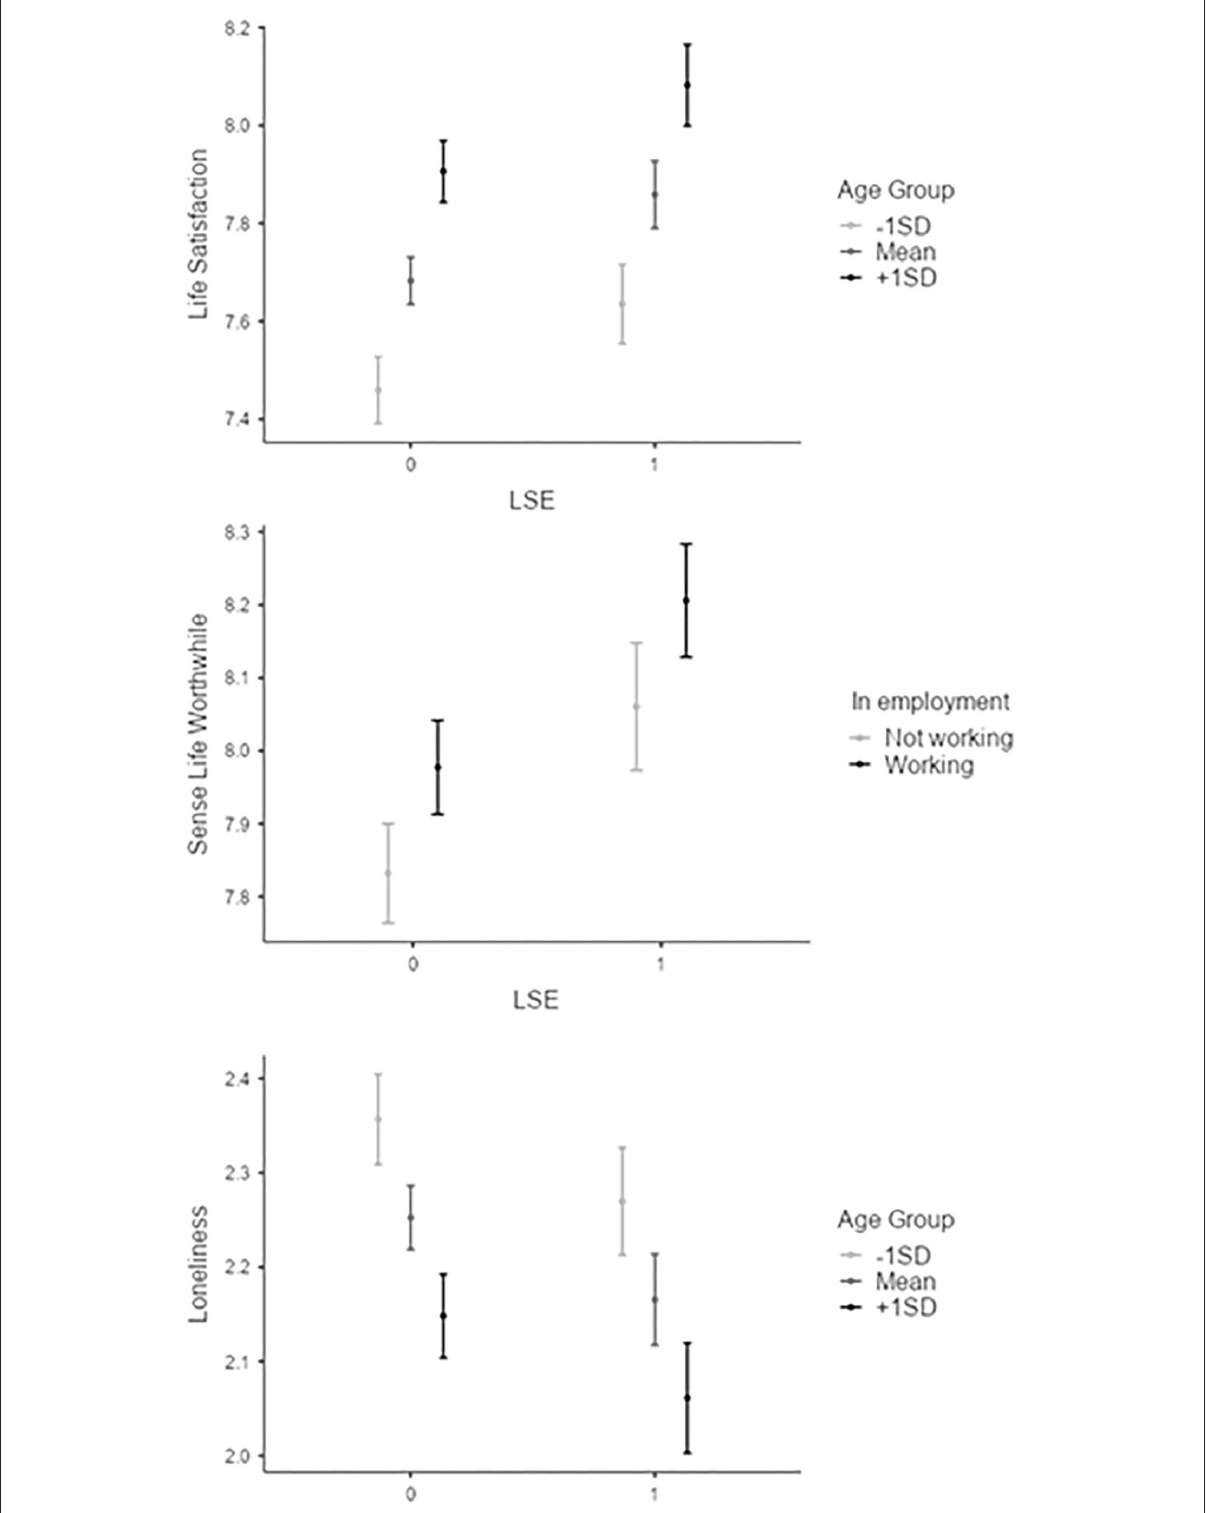
FIGURE1 Estimated marginal means for subjective wellbeing (SWB - life satisfaction, a sense that life is worthwhile), and loneliness by age group or employment and attendance at live sporting events (LSE). These plots indicate the magnitude of the effects seen alongside